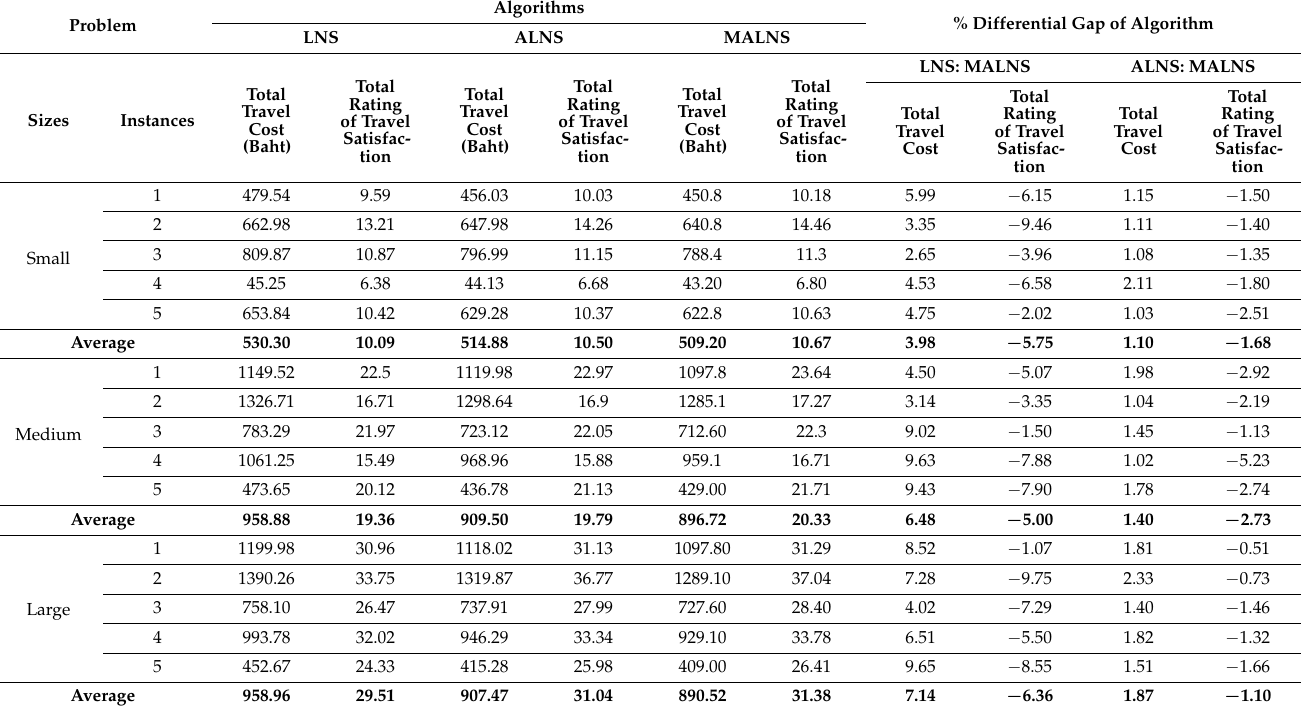
Table 5. Comparison of the differential gaps of the algorithms in tourism planning problem solving.